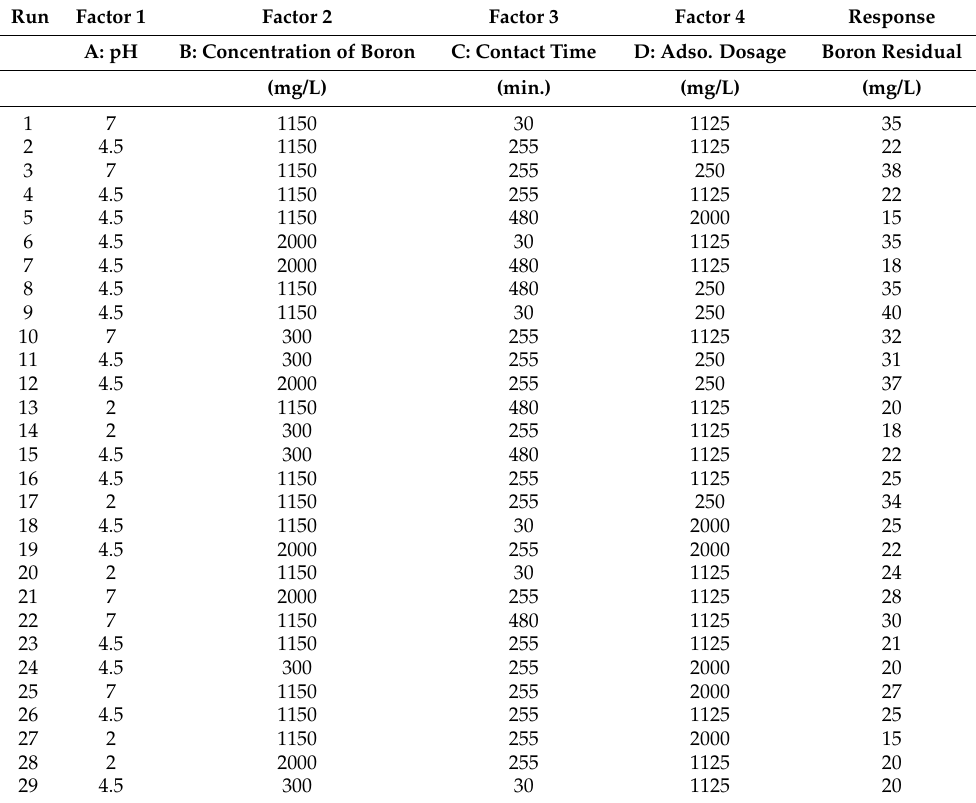
Table 2. Design of experiments matrix and the responses generated by Box–Behnken